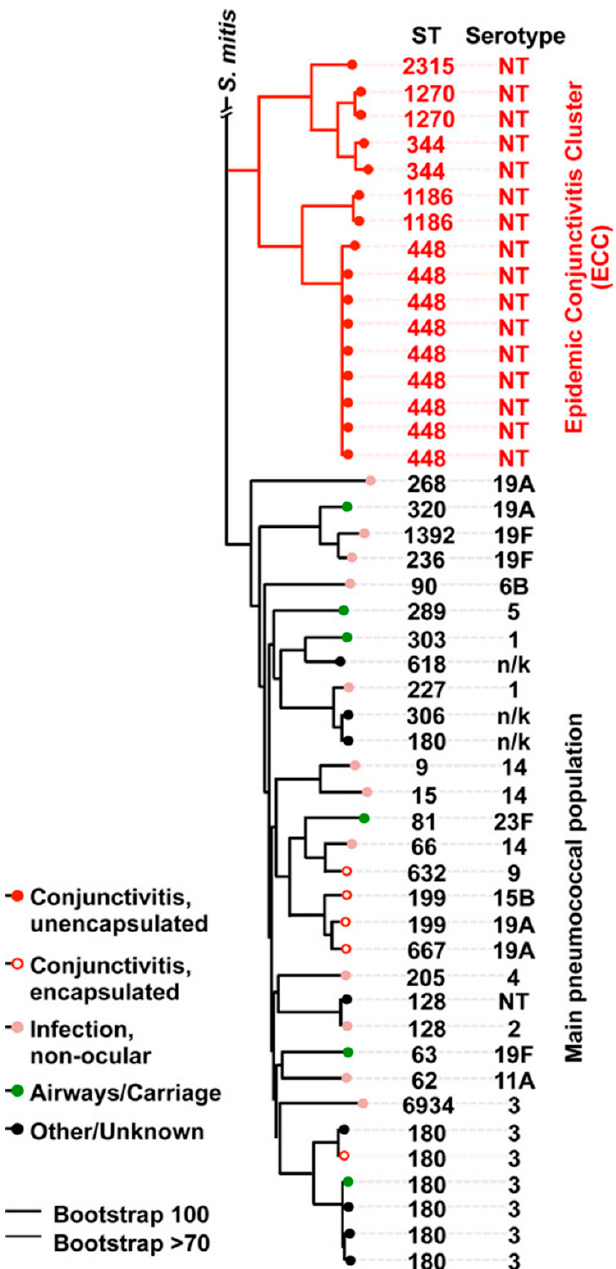
Figure 3. The distinct epidemic conjunctivitis cluster (ECC) of S. pneumoniae , consisting of ST448, ST344, ST1186, ST1270 and ST2315 (printed in red). Like Figure 2, this phylogenetic tree was constructed using PhyML, based on a concatenated set of 1160 core orthogroups, and which included S. mitis (strain B6) as a related group. Reprinted with author permission [10].